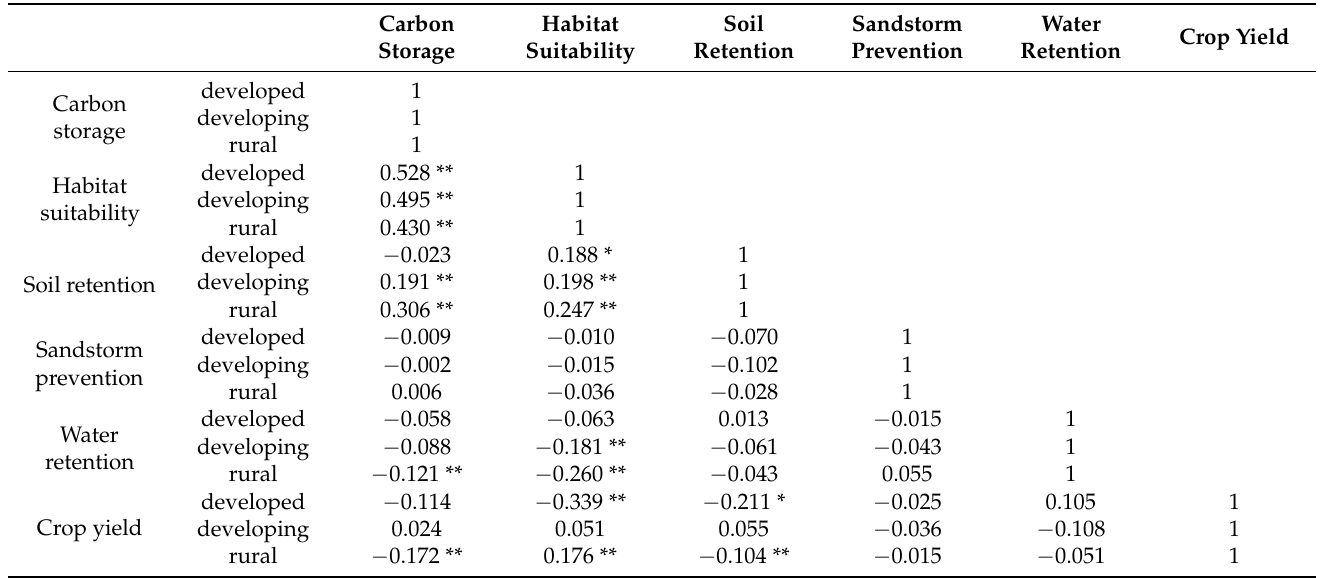
Table 3. Relationships between pairs of